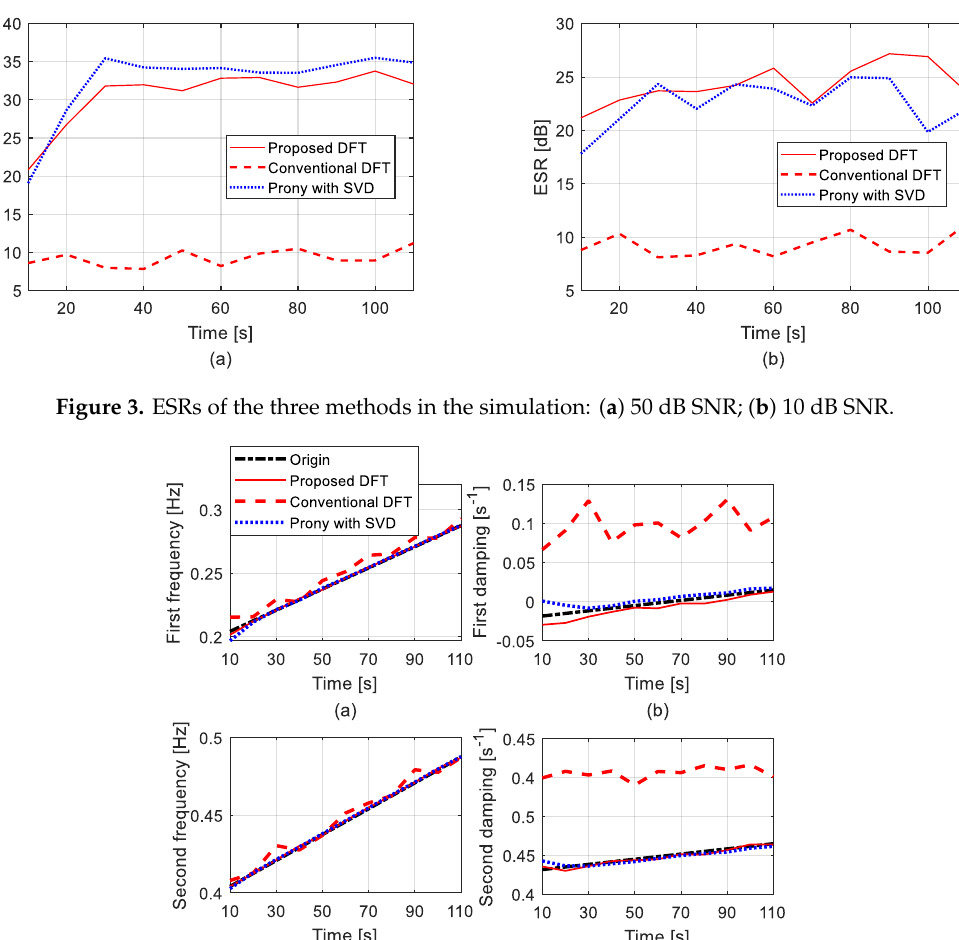
Figure 2. Modal oscillation signal and its estimated signals in the simulation with a 10 dB SNR: ( a ) 𝑥[𝑙] of the first segment and its estimated signals; ( b ) 𝑥 ̅[ 𝑙 ] of the first two combined segments and its estimated signal; ( c ) DFT magnitudes of the signals in (a); ( d ) DFT magnitudes of the signals in (b).